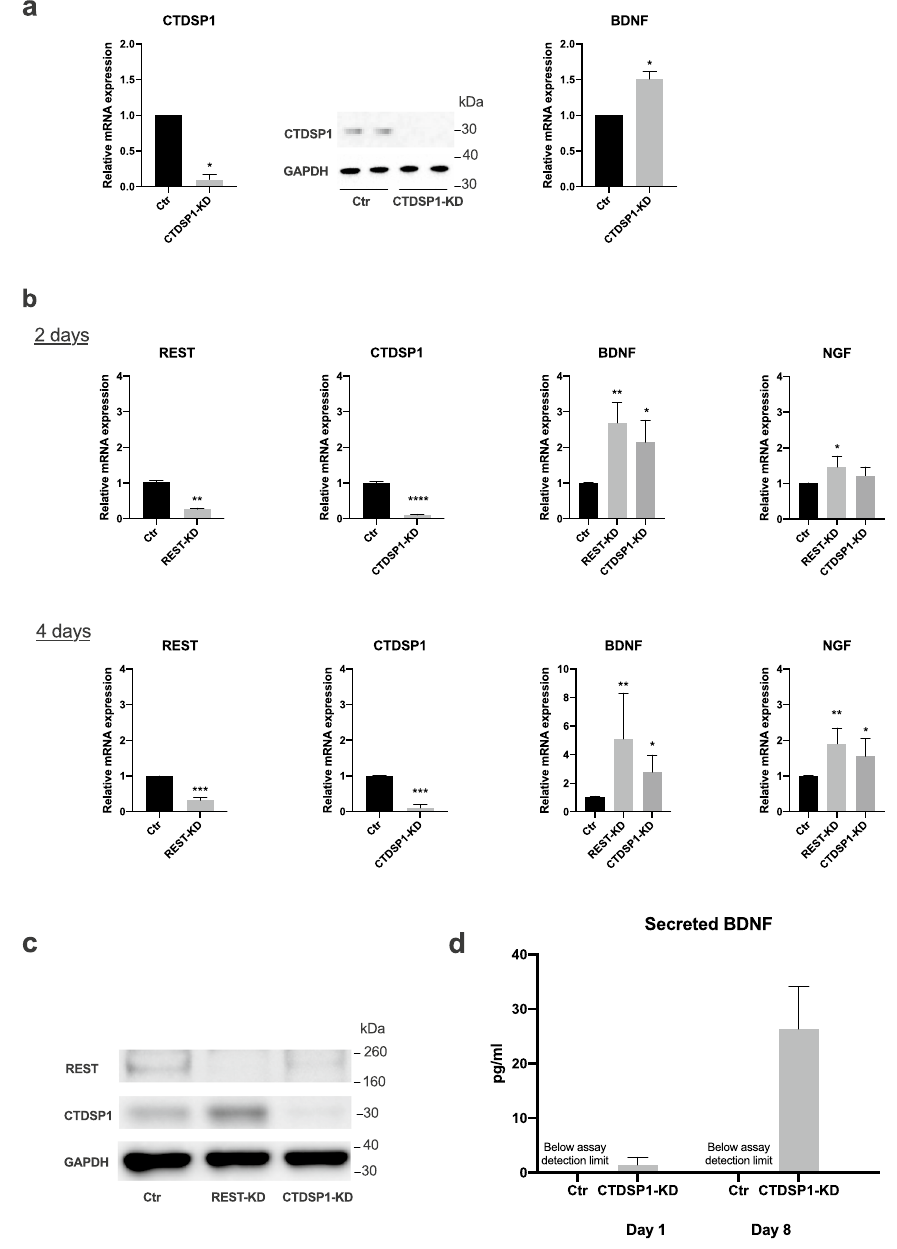
Figure 3. Knockdown of REST or CTDSP1 increases BDNF expression. ( a ) Quantification of mRNA and protein expression in HEK-293 cells 48 h after transfection of CTDSP1 siRNA. Knockdown of CTDSP1 was confirmed by qRT-PCR and Western blot analysis. BDNF mRNA levels were quantified by qRT-PCR. * p < 0.05, paired Student’s t -test with n = 3 biological replicates, error bars are SD. ( b ) mRNA expression levels in cultured MPCs 2 days and 4 days after transfection of siRNA. * p < 0.05, ** p < 0.01, *** p < 0.0001, **** p < 0.00001, two- tailed paired Student’s t -test (REST and CTDSP1) or Kruskal–Wallis test with Dunn’s multiple comparisons test (BDNF and NGF), with n = 5 biological replicates, error bars are SD. ( c ) Western blot analysis of protein expression levels of CTDSP1 and REST in MPCs 4 days after transfection of REST or CTDSP1 siRNA. GAPDH was used as loading control. Protein quantification shows a 75% reduction in REST protein after CTDSP1 knockdown. ( d ) Concentration of BDNF secreted in the MPC supernatant over 24 h measured by ELISA 1 day and 8 days after transfection of CTDSP1 siRNA. Control samples showed signal below the detection limit of the assay. Four samples were analyzed for each condition, error bars are SD. For all graphs: Ctr = control scramble siRNA, KD = knockdown. Full-length blots are shown in Supplementary Figures S2 and